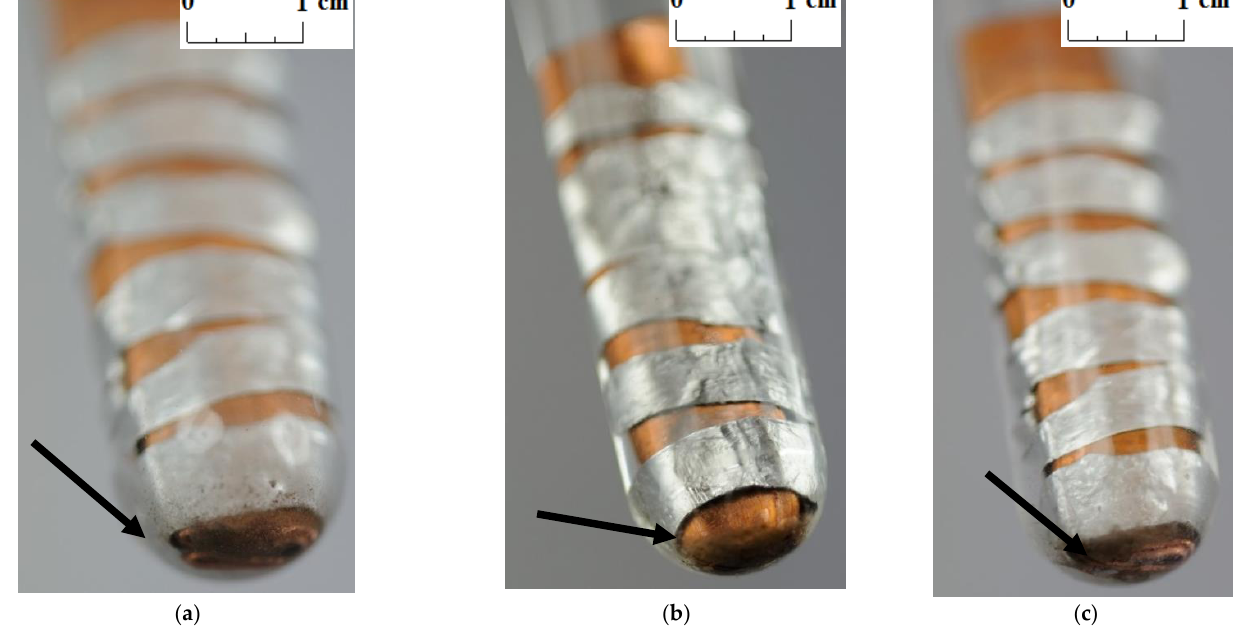
Figure 6. The precipitate which deposited on the sample with a combination of aluminum and copper immersed in RT18 HC; ( a ) after 3 weeks; ( b ) after 4 weeks; and ( c ) after 7 weeks.